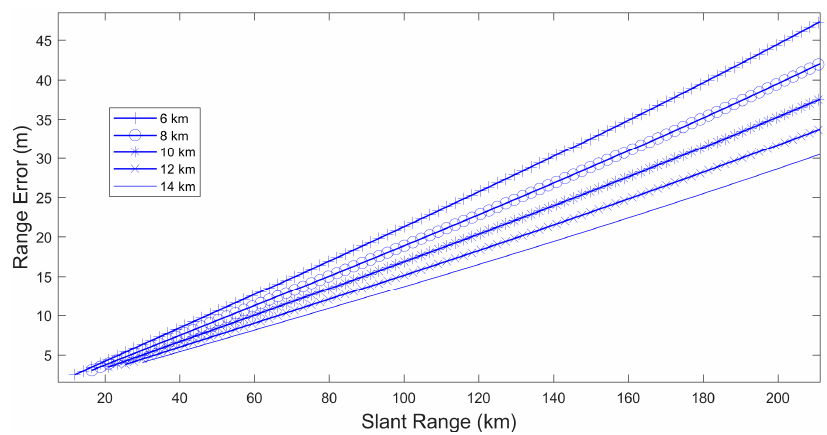
Figure 7. Range bias for aircraft at different altitudes.